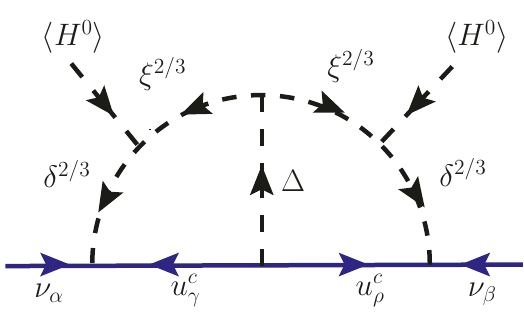
Figure 58 . A new example of type-II radiative neutrino mass